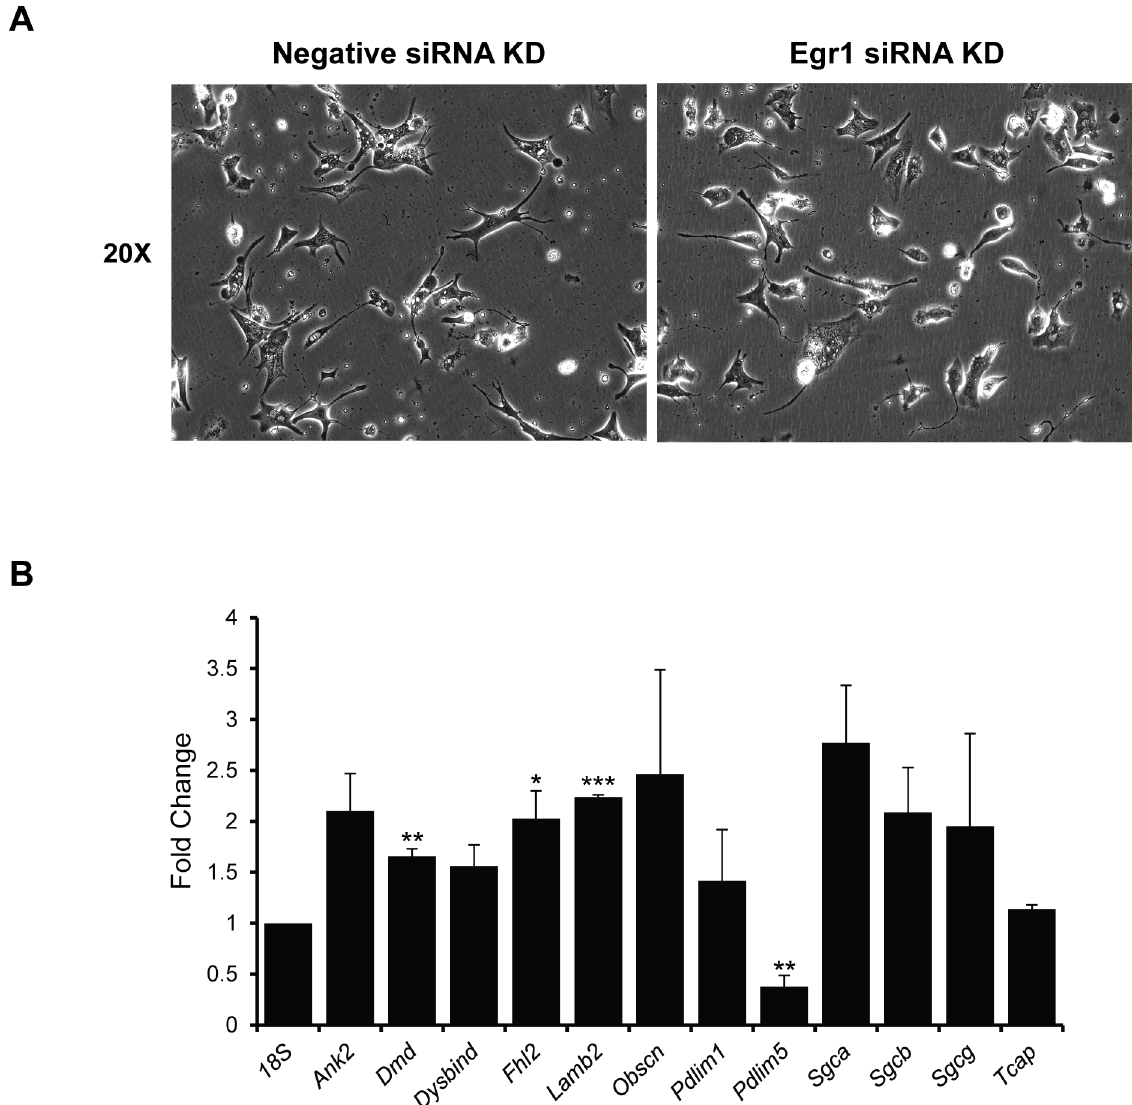
Fig 5. Costamere gene expression is upregulated in EGR1-depleted NRVMs. (A) EGR1 depleted NRVMs do not display any obvious morphological defects. NRVMs were transfected with 100 nM EGR1 siRNA and analyzed 72 hours post transfection. (B) HEK 293T cells were transfected with pcCMV-EGR1-Flag, and either a negative control or Egr1 siRNA. Western blot analysis probing for the Flag epitope shows loss of EGR1-Flag expression upon co-transfection with the Egr1 siRNA, though a confounding non-specific band is present slightly above the EGR1-Flag band. (C) EGR1-depletion results in upregulated costamere gene expression in NRVMs. qRT-PCR analysis of 13 MEF2-dependent costamere genes in EGR1 siRNA knockdown NRVMs shows that eight of the genes are significantly upregulated, and the majority of the remaining genes show a nonsignificant trend towards upregulationwhen EGR1 is knocked down; fold change is in comparison to expression levels in the negative siRNA knockdown controls, results were normalized to 18s. Sample size for Ank2, Dmd, Dysbind, Lamb2, Pdlim1, Sgcb, and 18s is n = 6. Sample size for Pdlim5, Sgca, Sgcg, and Tcap is n = 5. Sample size for Fhl2 and Obscn is n = 4, and the sample size for Xirp2 is n = 3., * p < 0.05, ** p < 0.01, *** p <